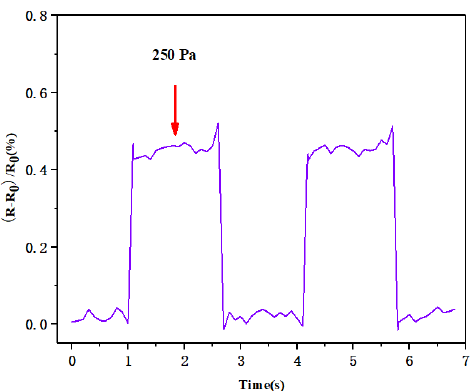
Figure 10. Real-time response test of the flexible pressure sensor for repeated loading/unloading of low pressure (250 Pa). low pressure (250